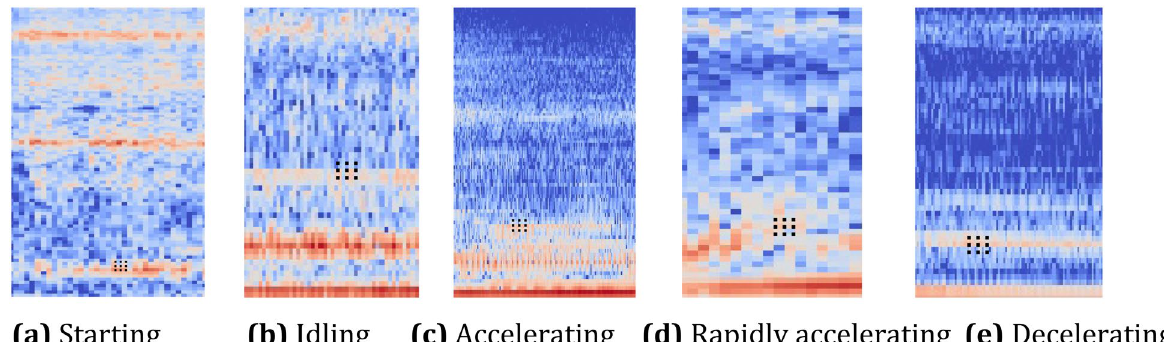
Figure 3. Conventional convolution sampling positions in logarithmic Mel